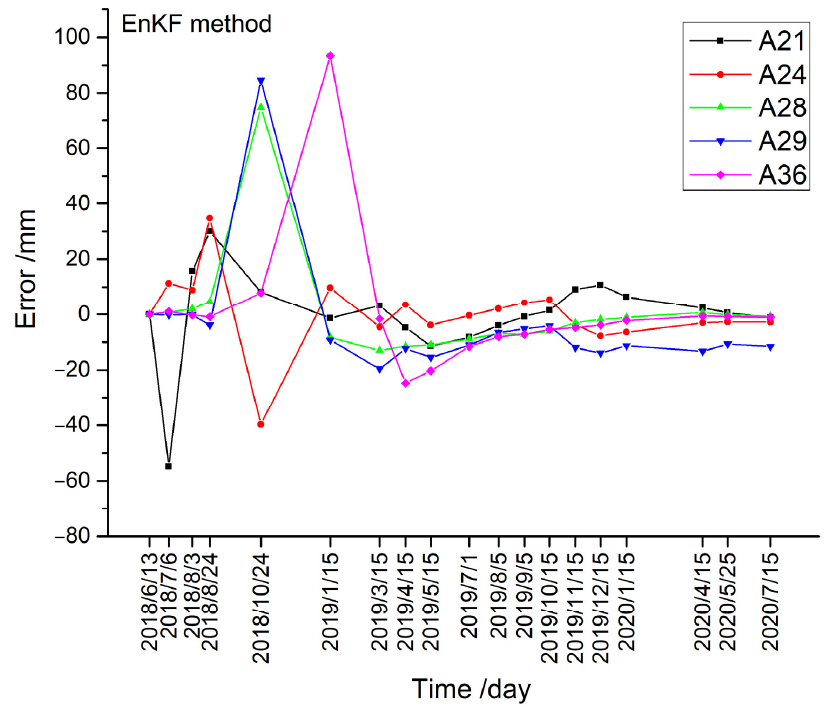
Figure 11. Error curves of the typical points using the EnKF method.